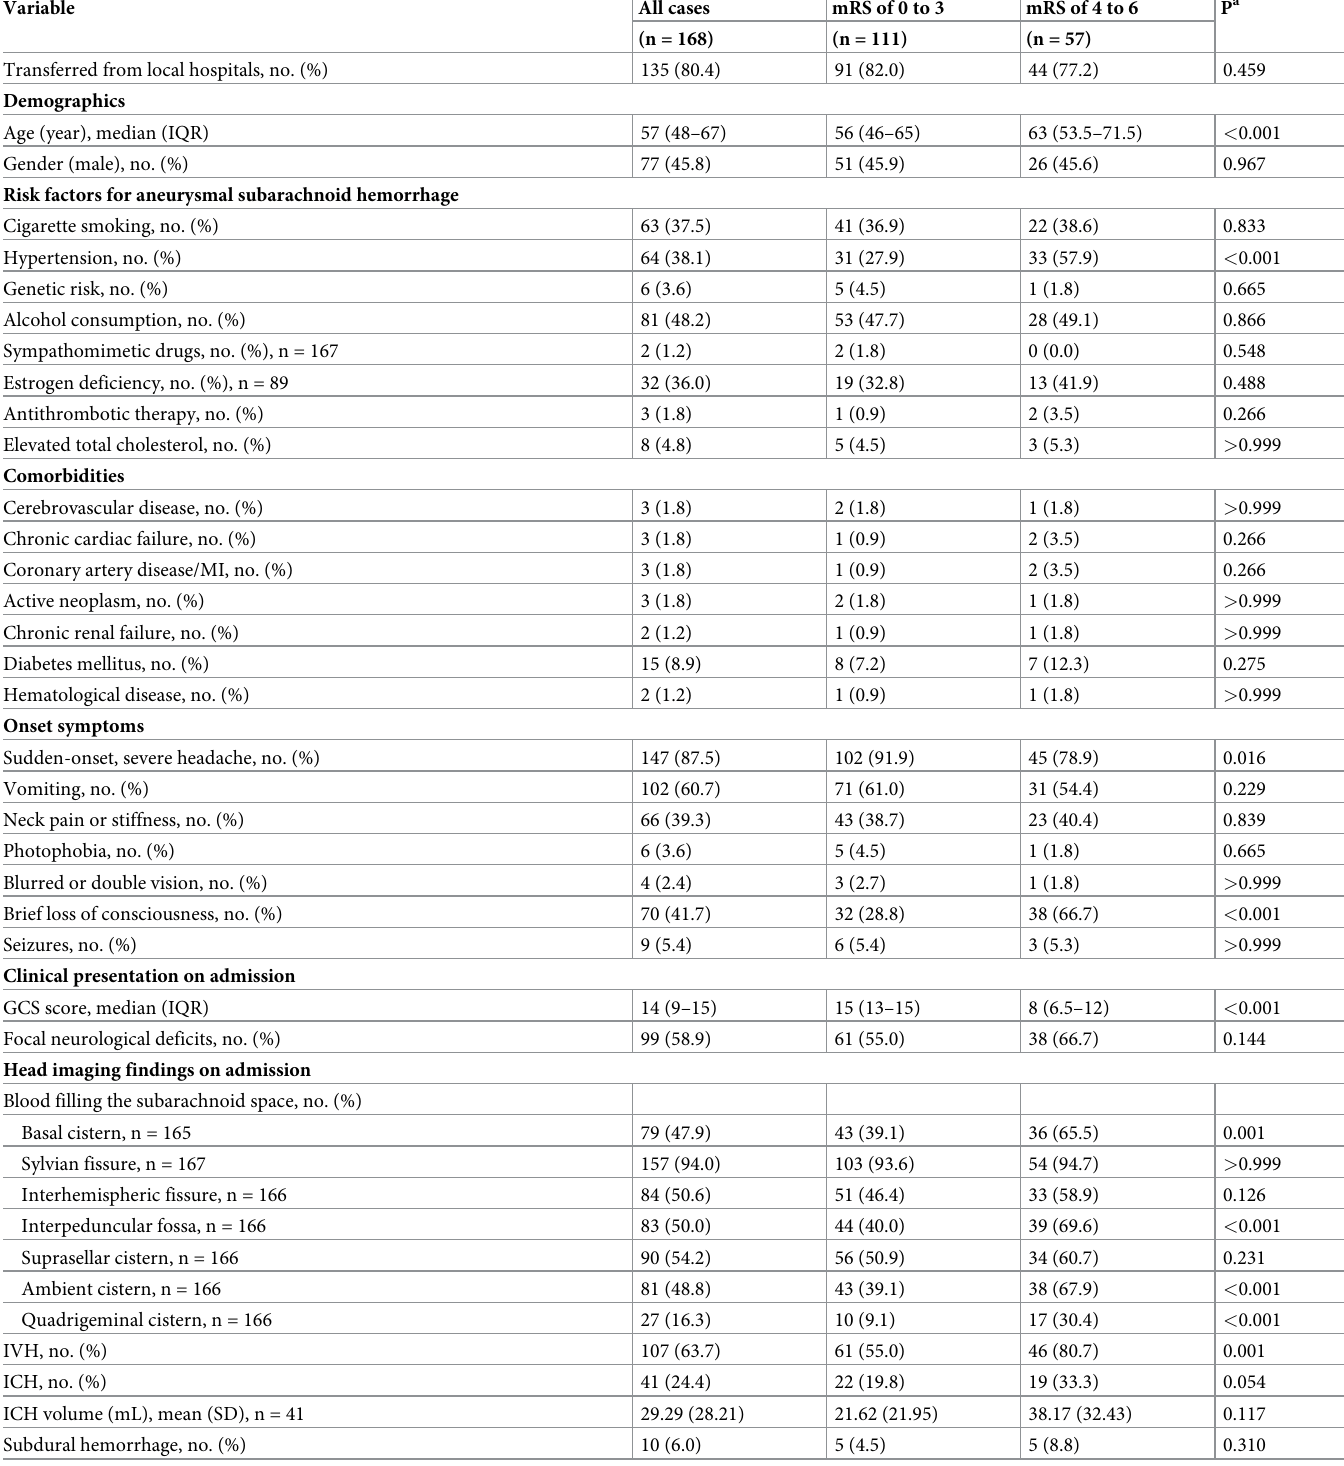
Table 2. Demographic and baseline characteristics, management and outcomes of patients with aneurysmal subarachnoid hemorrhage according to neurologic function at 90 days after the onset of